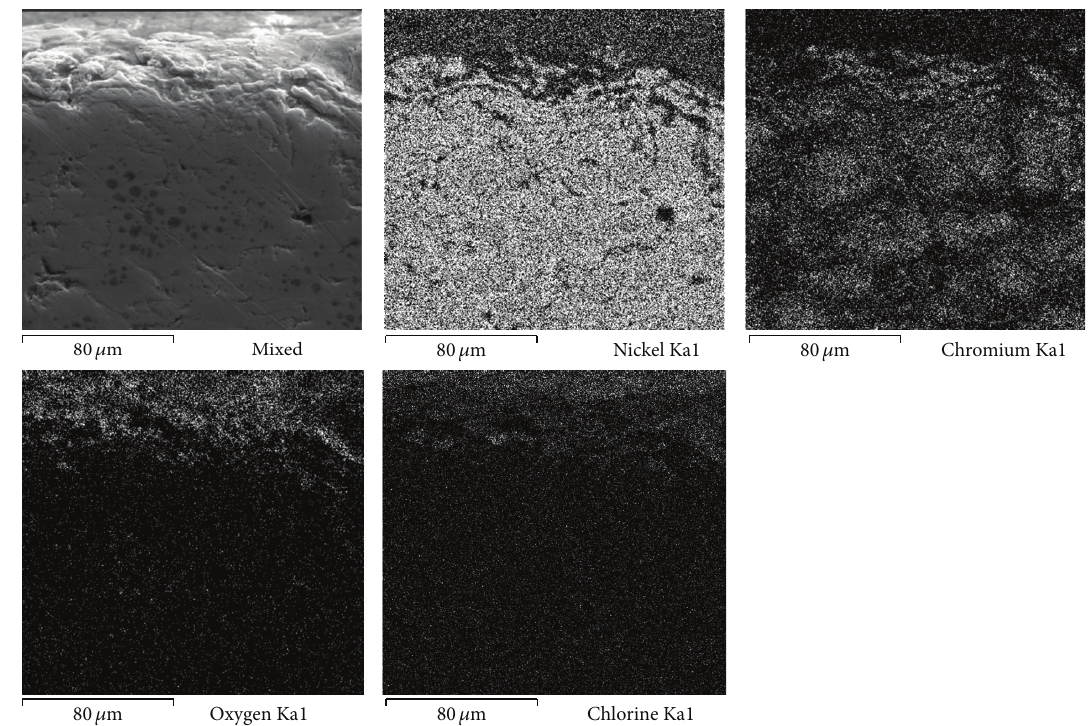
Figure 12: Cross-sectional aspect of the Ni20Cr as-grinded coating and elements distribution after corrosion test at 450 ∘ C.